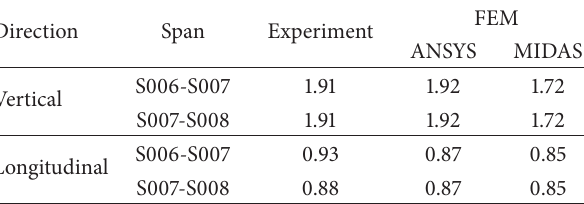
Table 4: Comparisons for natural frequencies between finite ele- ment method and the field